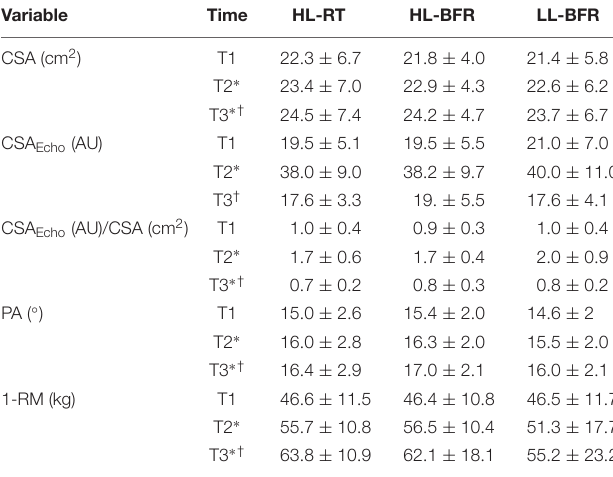
TABLE 1 | Muscle cross section area (CSA), CSA echo intensity (CSAecho), CSAecho to CSA ratio, pennation angle (PA) and maximum dynamic strength test (1-RM) at baseline (T1), after 5 (T2), and 10 weeks (T3) for high-load resistance training (HL-RT), high-load resistance training with blood flow restriction (HL-BFR) and low-load strength training with blood flow restriction